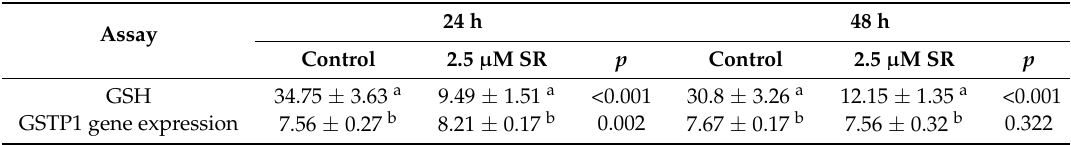
Table 1. GSH content and GSTP1 gene expressions of PBMCs grown for 24 h and 48 h in the absence (control) and in the presence of SR (2.5 µ M). Data are reported as absolute values (mean values ± S.E., n = 8 subjects). The p -values were calculated by comparing the control values with the 24 h SR incubation samples, and with the 48 h SR incubation samples.